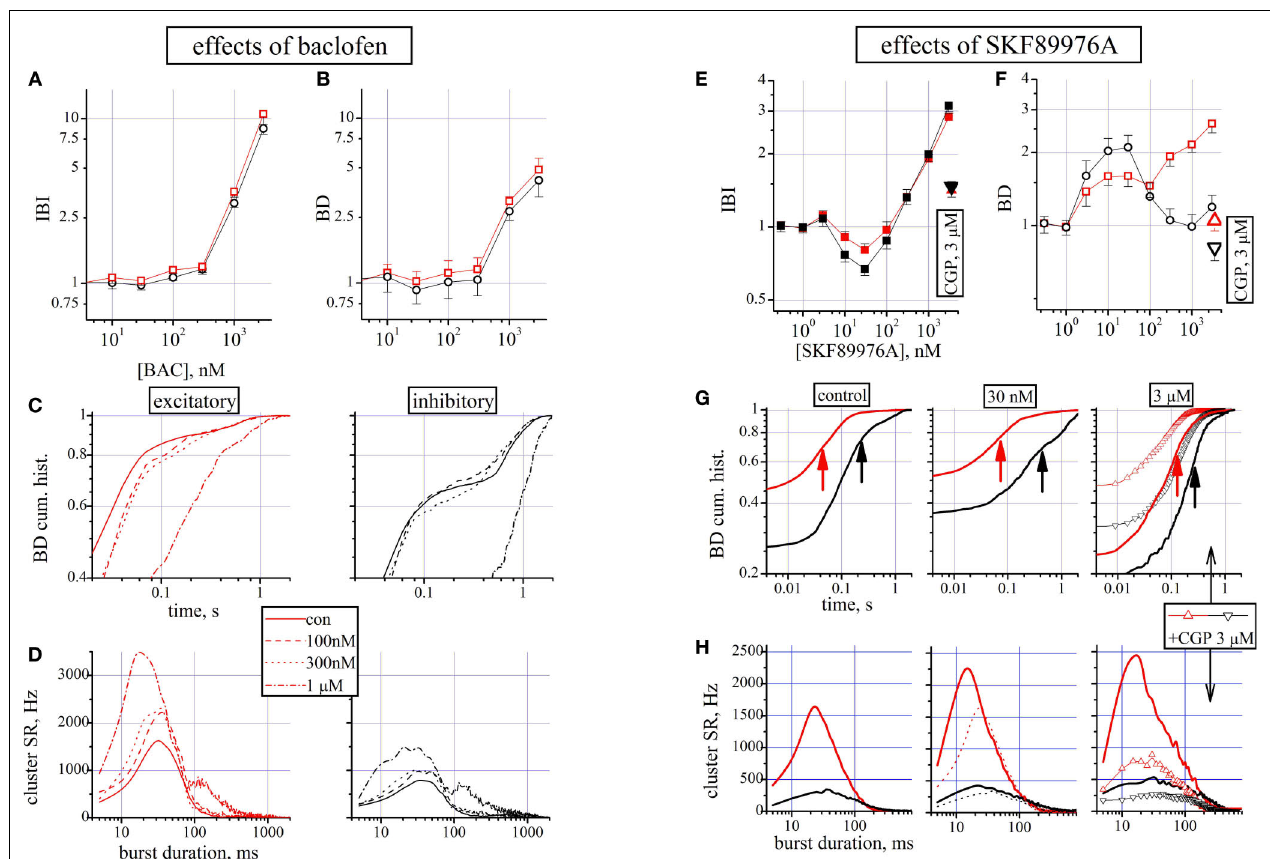
data are shown as triangular symbols. (G) For one of the three experiments and the two cell clusters, the BD cumulative histograms are shown in control (left panel), in 30 nM (middle) and in 3 µM (right) SKF. Arrows indicate the mean values. Data with triangles show the results after the CGP addition on top of SKF. For the same experiment shown, the BD values for the excitatory (inhibitory) clusters were: 45 ± 5 (212 ± 34 ms) ms in control, 73 ± 17 (450 ± 99 ms) ms in 30 nM SKF and 121 ± 13 (257 ± 48 ms) ms in 3 µM SKF, n = 52 and 11 respectively. The average IBI values for the two clusters were: 6.7 ± 0.2 and 5.8 ± 0.3 s in control, 5.5 ± 0.32 and 3.9 ± 0.23 s in 30 nM SKF and 19.3 ± 0.6 and 18.3 ± 0.98 s in 3 µM SKF. (H) From the same experiment shown in (G) , the average cSR recorded during the bursts in control (left) and in 30 nM (middle, dotted lines replicate data in control) and 3 µM (right) SKF. In the last panel the data of the effect of adding 3 µM CGP on top of SKF is shown, as indicated, in triangle + line